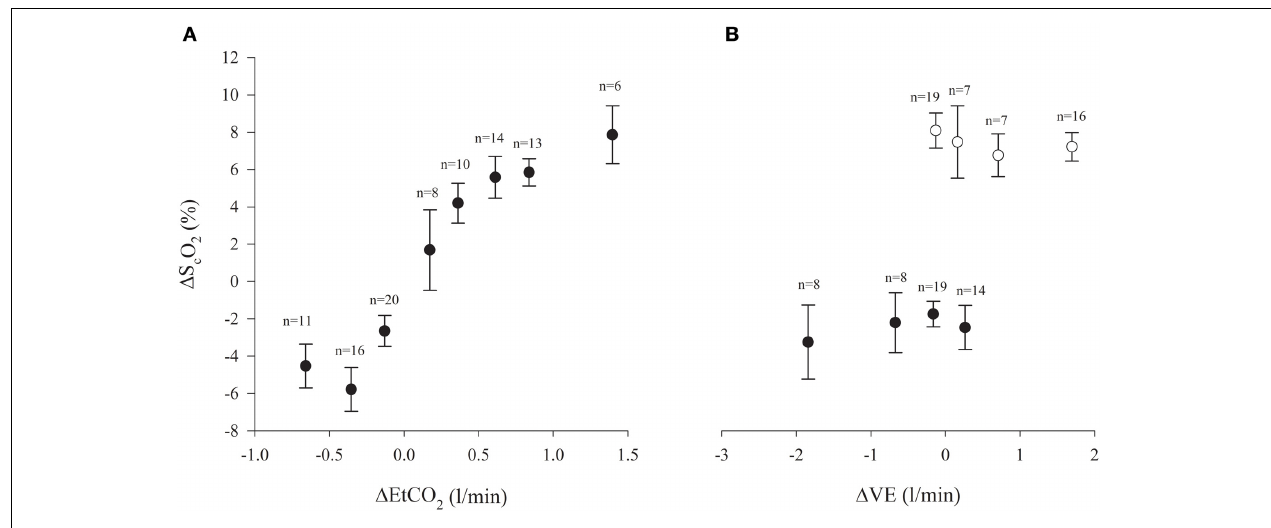
FIGURE 2 | (A) Frontal lobe oxygenation (S c O 2 ) and end-tidal CO2 tension (EtCO 2 ) in the anhepatic and reperfusion phases of liver transplantation surgery (% changes from baseline; ± s.e.m.) (Pearson r = 0 . 74; P < 0 . 0001). Number of subjects indicated. (B) Changes